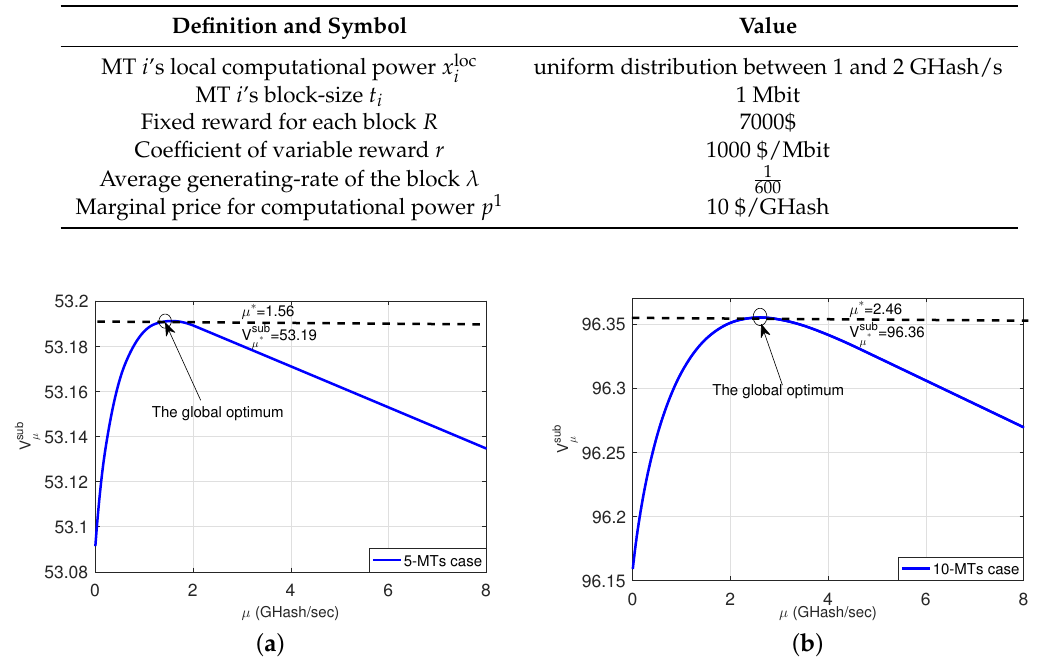
Table 1. Important parameter settings.